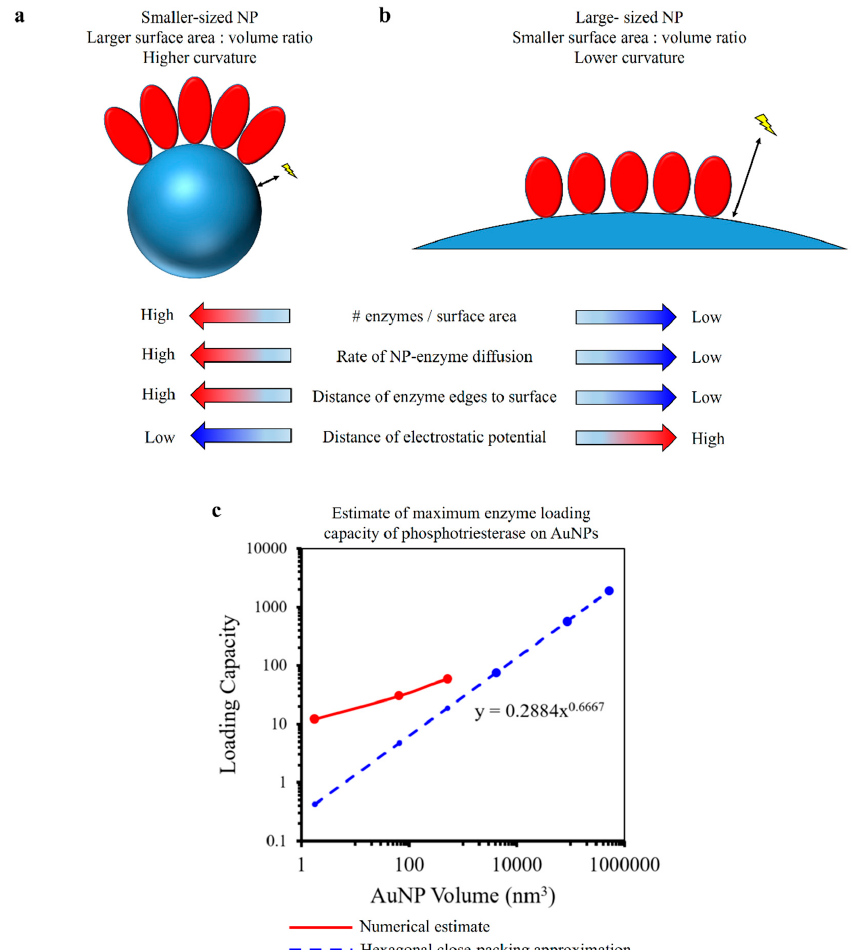
Figure 2. Nanoparticle (NP) size influences NP–enzyme complexes ( a ) A smaller-sized NP has a larger SA:V and higher curvature, resulting in a higher potential loading capacity of enzymes per SA, a higher rate of NP–enzyme di ff usion (can limit overall activity less), a higher distance of enzyme edges to surface (can help stability), and a lower distance of electrostatic potential (less influence on local pH; indicated by arrows and lightning bolts) ( b ) A larger sized NP, conversely, has a smaller SA:V and a lower curvature. ( c ) Examining the AuNPs Breger et al. used in terms of AuNP volume, a numerical estimation and the hexagonal close-packing (HCP) approximation of the loading capacity indicate a relatively small gain in loading capacity for large increases in volume, which correlates to total Au used and presumably price. Initial values draw from Breger et al., and utilized for subsequent analysis here